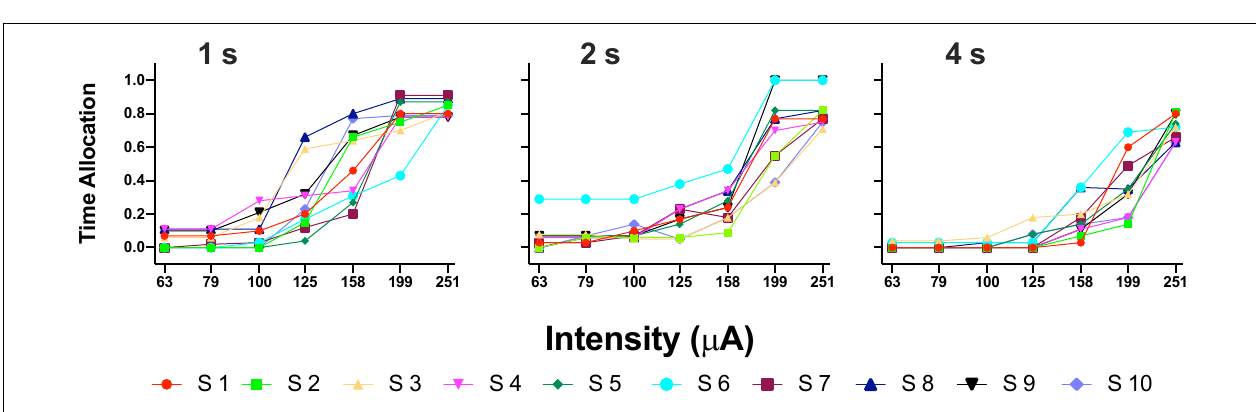
FIGURE 3 | Time allocation as a function of variations of intensity (in common scale, see text) and price (hold requirements). Abscissas in log scale. (A) Exemplar rat. (B) Remaining rats.